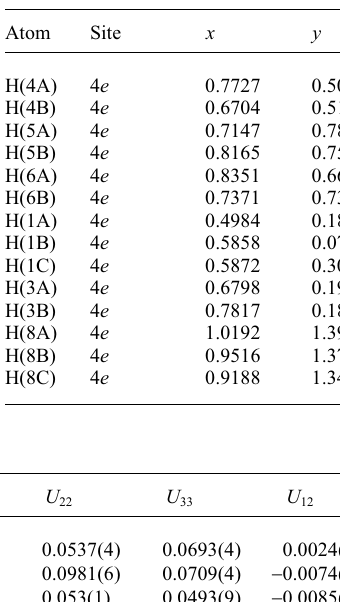
Table 2. Atomic coordinates and displacement parameters (in Å 2 ) .